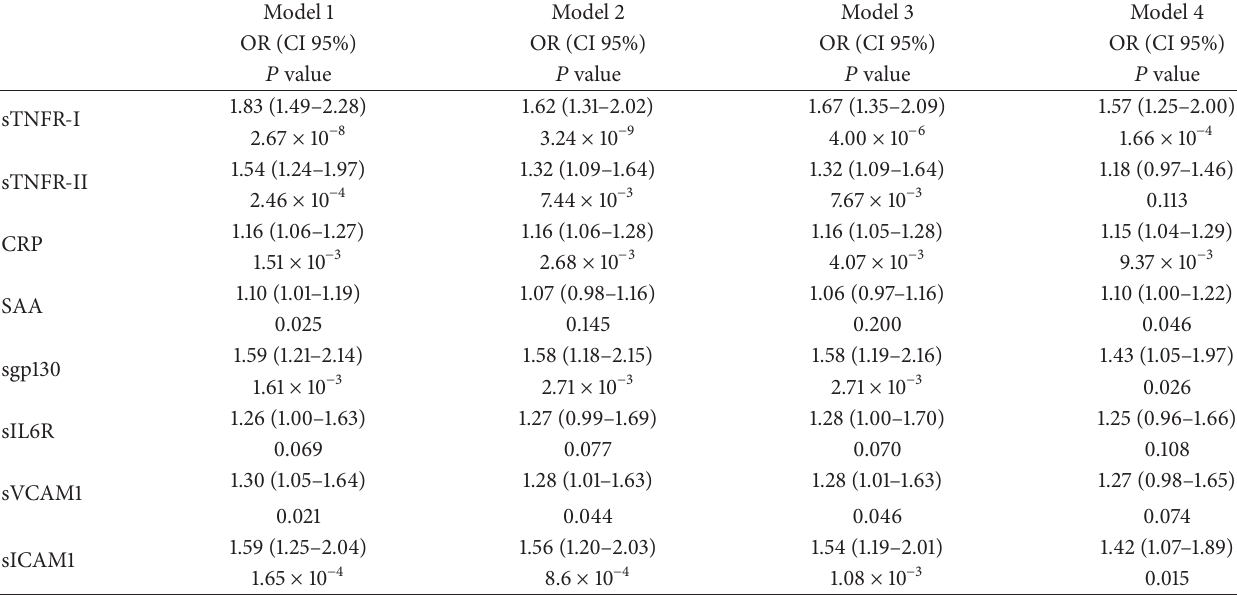
Table 2: Multivariate logistic regression analysis for proteins after adjustment for age, sex, and disease